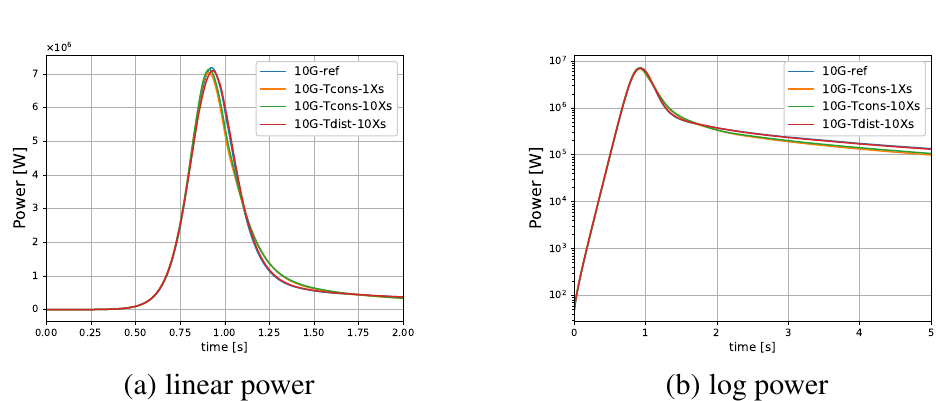
Figure 8: Power solutions to the 1-D homogeneous problem in 10 energy groups